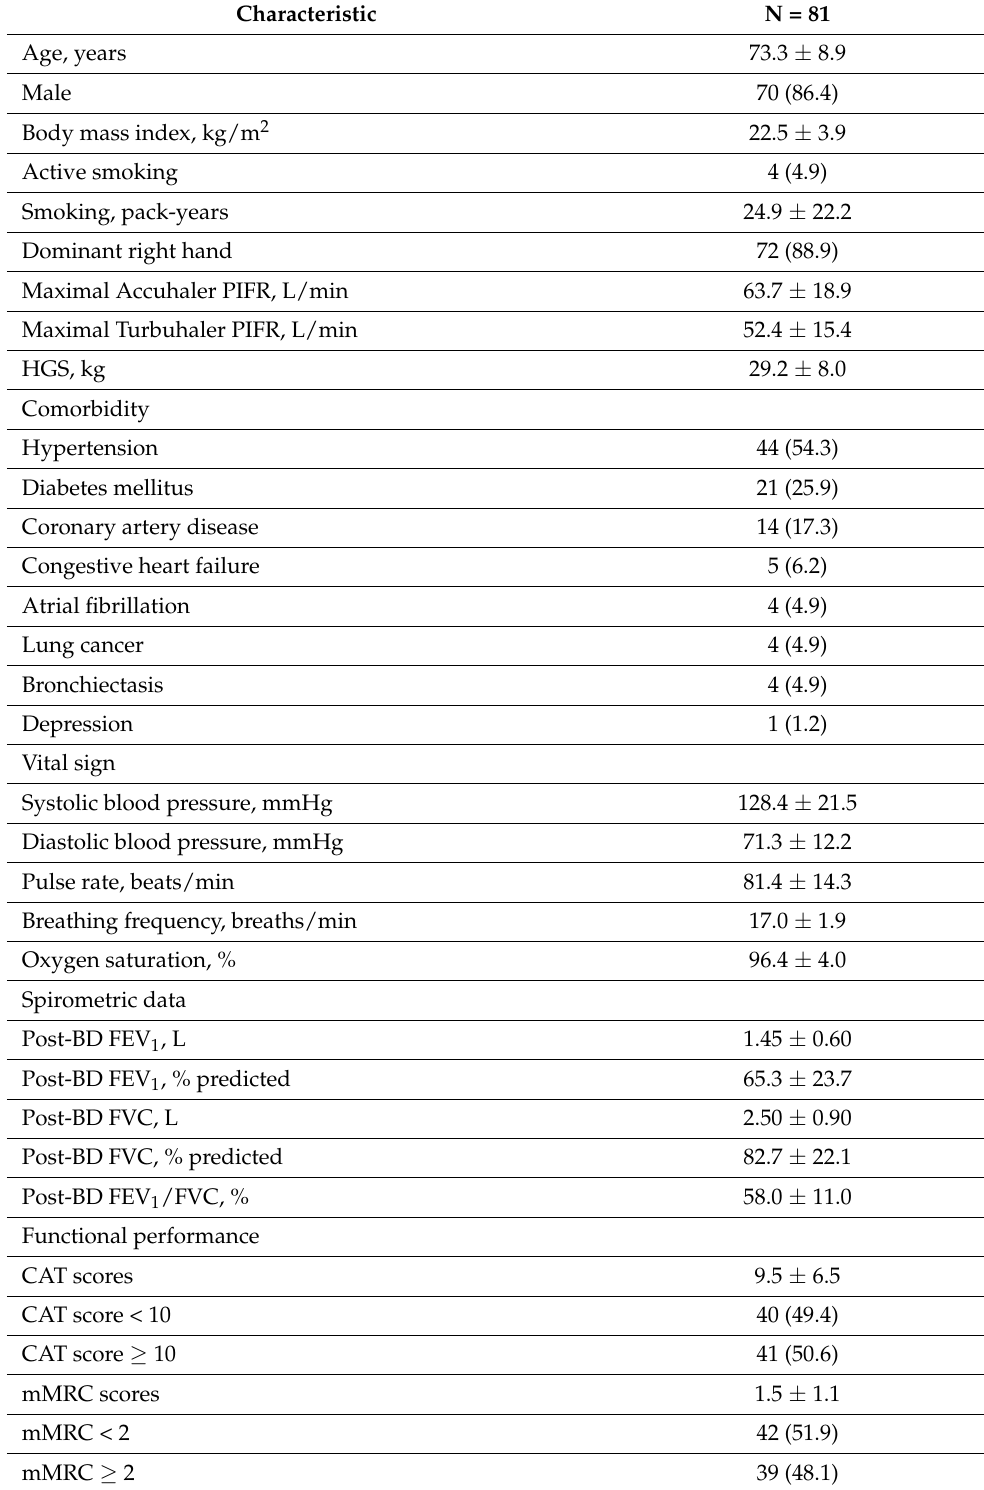
Table 1. Baseline characteristics of clinically stable patients with chronic obstructive pulmonary